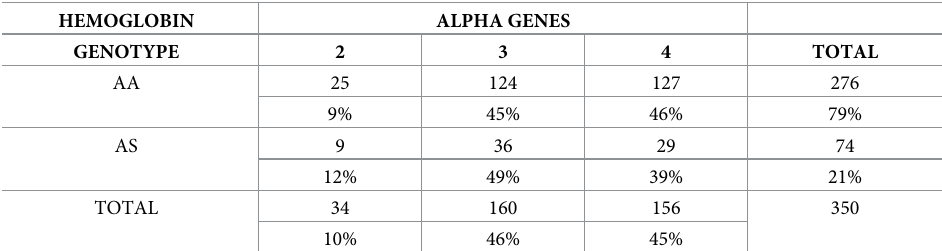
Table 1. Prevalence and assortment of hemoglobin genotype (HbAA and HbAS) and α -globin gene numbers.